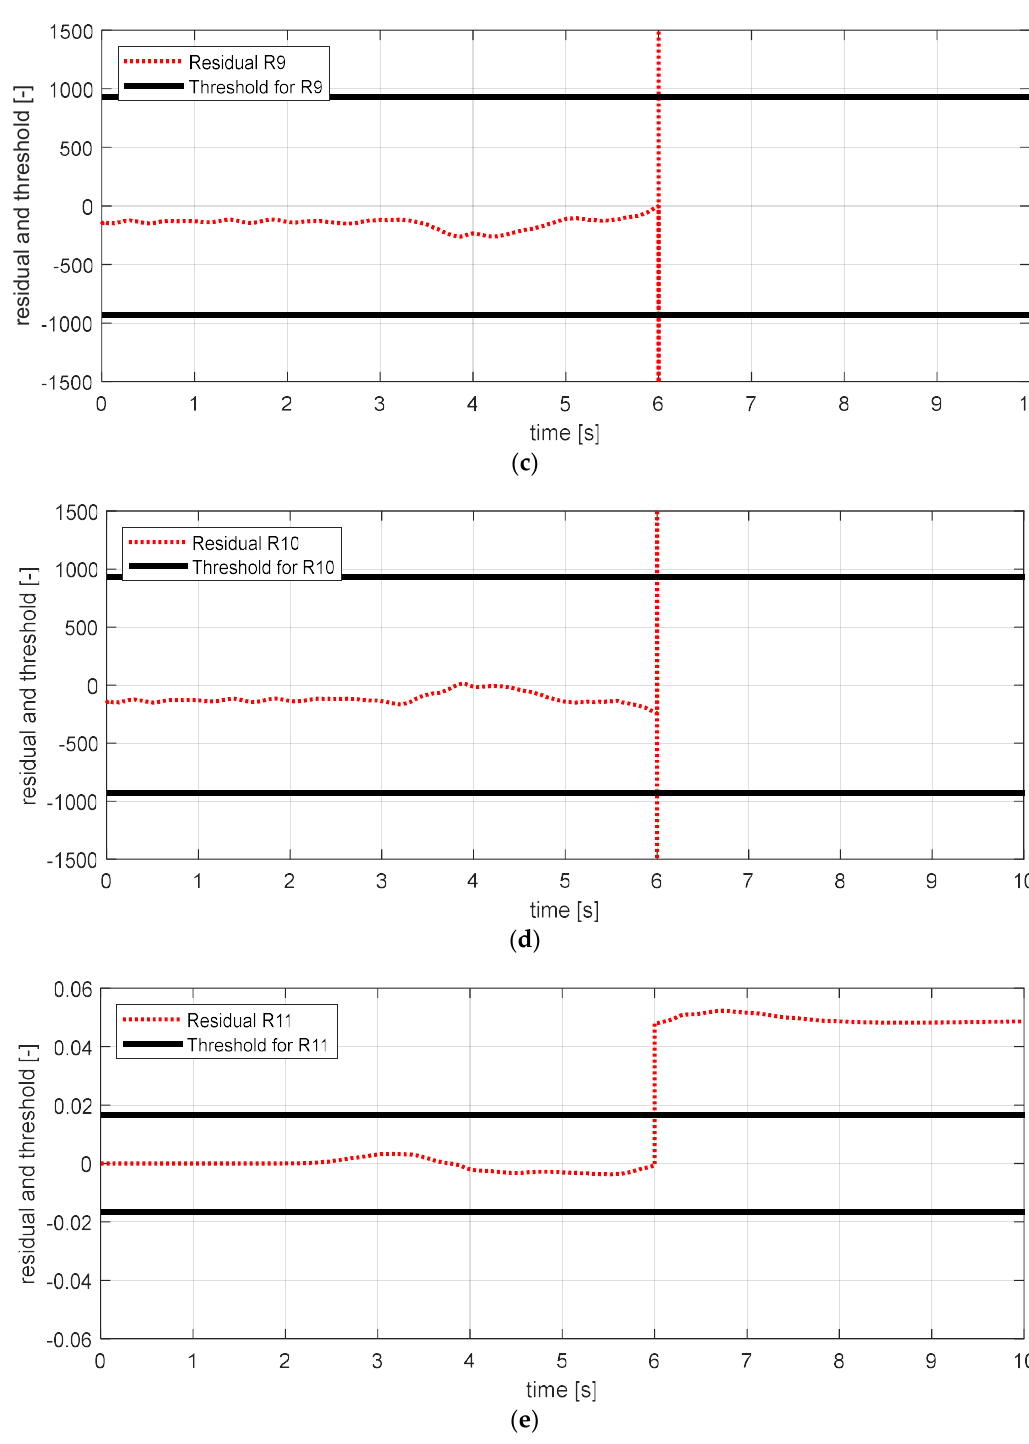
Figure 22. FDI simulation result for lateral acceleration sensor (fault). ( a ) Residual 7 and threshold; ( b ) residual 8 and threshold; ( c ) residual 9 and threshold; ( d ) residual 10 and threshold; ( e ) residual 11 and threshold.